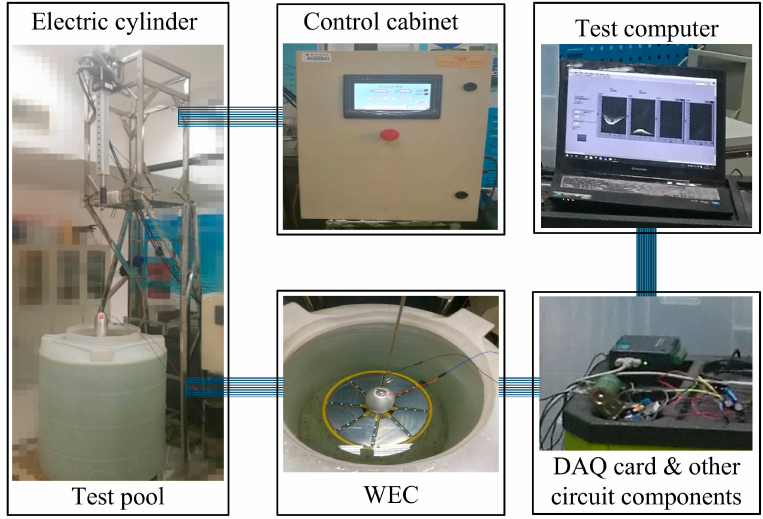
Figure 21. Test Pool test